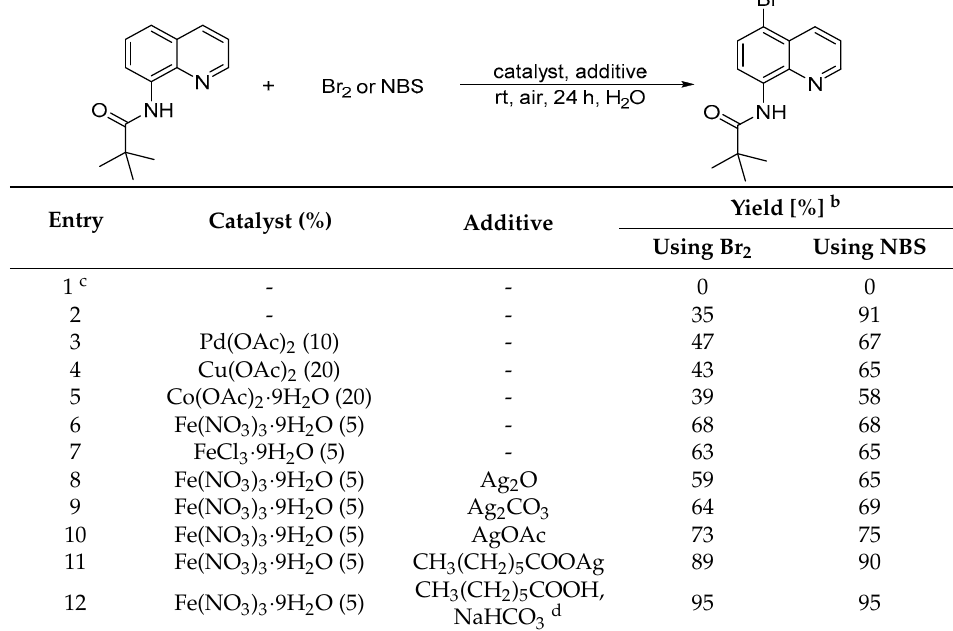
Table 1. Optimization of the reaction conditions.